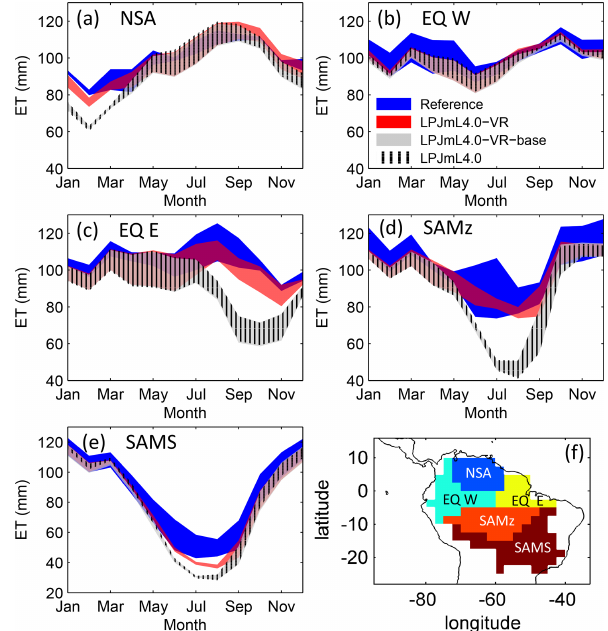
Figure 3. Comparisons of continental-scale gridded ET products against simulated ET within five regional climatological clusters (a–e) as defined in Sect. 2.5.1. Shown is the mean annual cycle of 1981–2010 and the mean for the whole cluster area. Corridors de- note the minimum–maximum range between either the Reference ET products (Sect. 2.5.1, “Validation data”) or the model outputs under the different climate forcings used in this study. (f) Geograph- ical extent of climatological clusters (adapted from Sörensson and Ruscica, 2018). Statistical measures of the individual comparisons can be found in Table B3 (comparisons of corridor